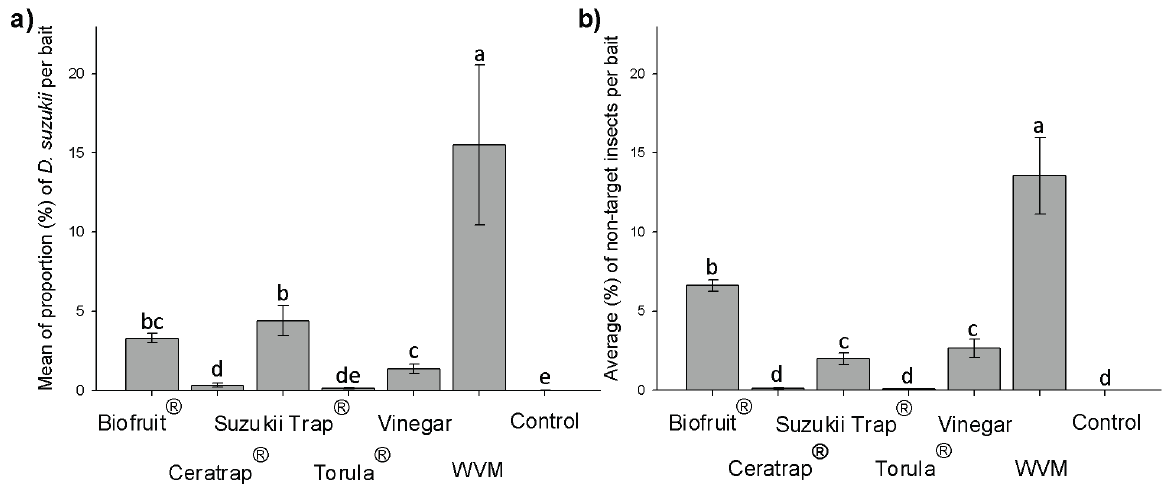
Figure 1 - ( a ) Means ± standard error (%) of Drosophila suzukii insects (males and females) captured with different food baits in a blackberry orchard; ( b ) Means ± standard error (%) of non-target insects captured with different food baits in a blackberry orchard. Means sharing the same lower case letter are not significantly different (Tukey’s HSD, α = 0.05).